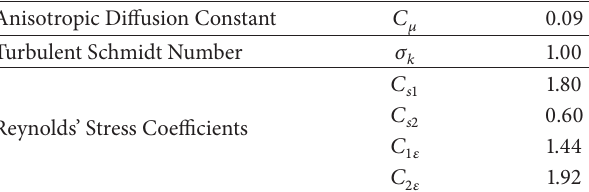
Table 2: Constant and coefficients used in RS Model.